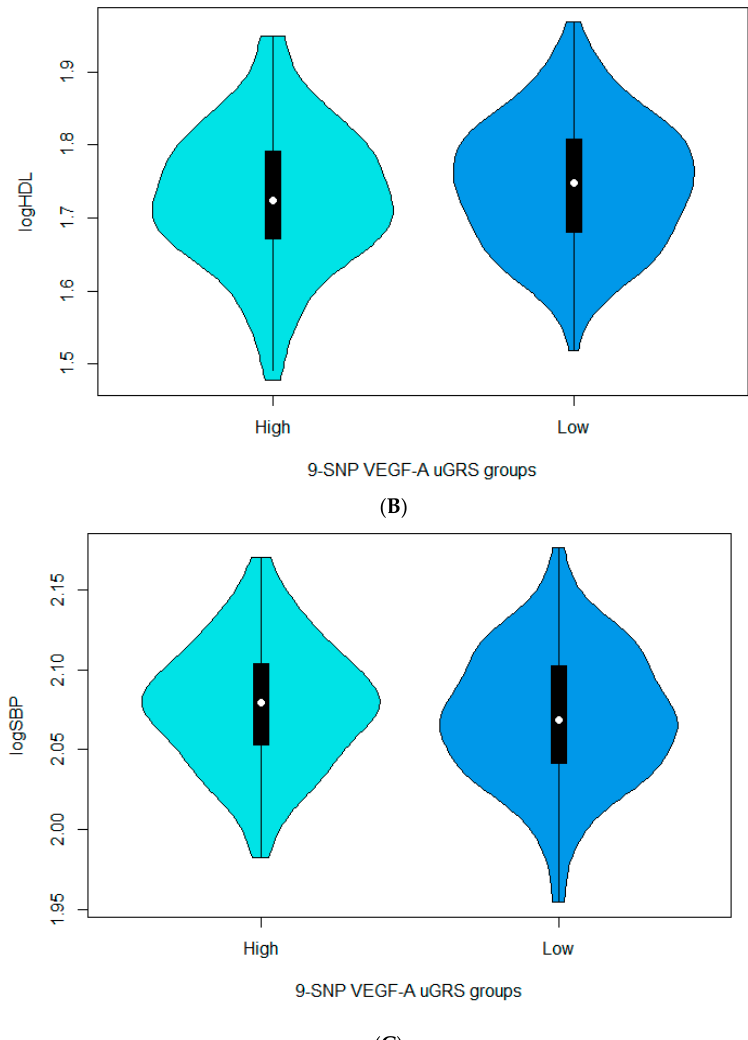
Figure 1. Violin plots depicting the distribution of ( A ) logBMI, ( B) logSBP and ( C ) logHDL between the two groups of the 9-SNP VEGF-A unweighted GRS (low versus high), separated by the sample median ( p -values < 0.05).